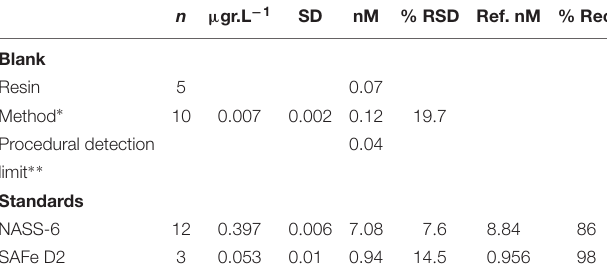
TABLE 3 | Blanks and standard